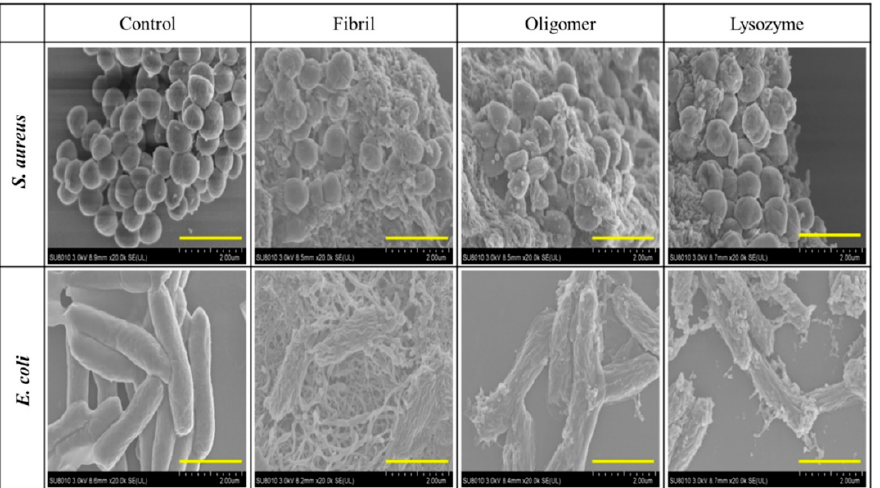
Figure 3. SEM images of S. aureus and E. coli under the exposure of buffer (Tris − HCl, pH 7.2, control), HEWL fibril, HEWL oligomer, and HEWL after 6 h. Scale bar, 2 µm. “Reprinted with permission from [53]. Copyright © 2022 American Chemical Society”.